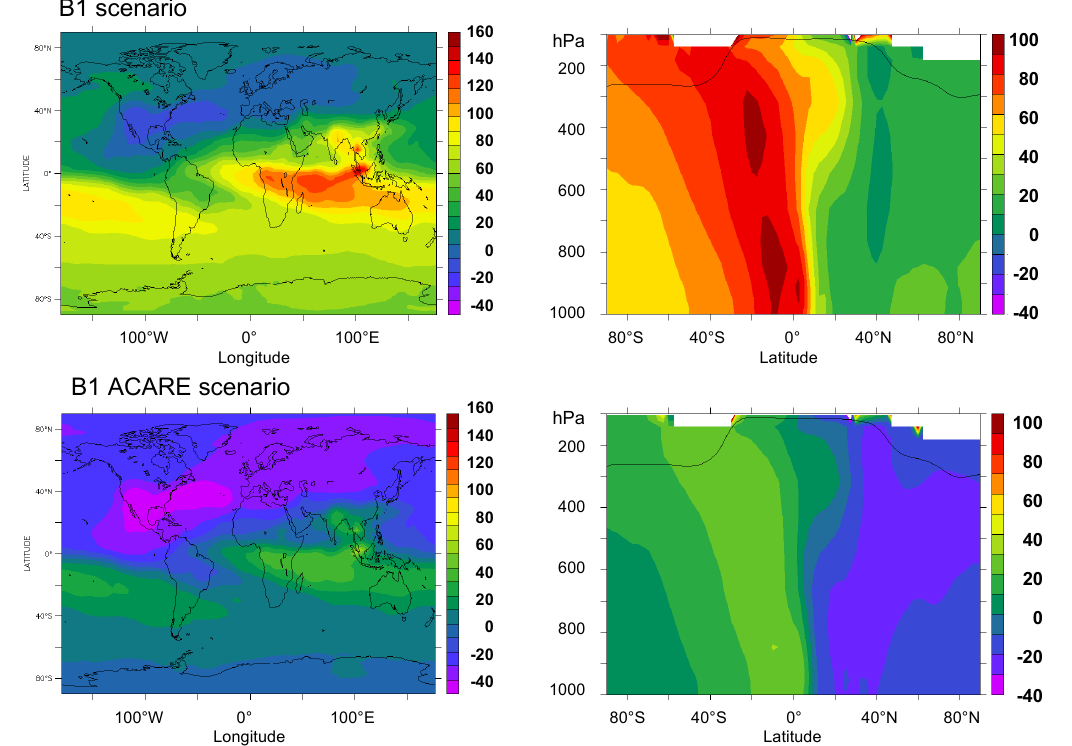
Fig. 6. (a) Perturbations in zonal mean ozone mixing ratio (in %) due to aircraft emissions, for July from 2000 (left), 2050 B1 (middle) and 2050 B1 ACARE (right) emissions; (b) 2000–2050 changes (%) in the O 3 tropospheric column and zonal mean ozone perturbations by aircraft emissions for B1 scenario, and (c) B1 ACARE